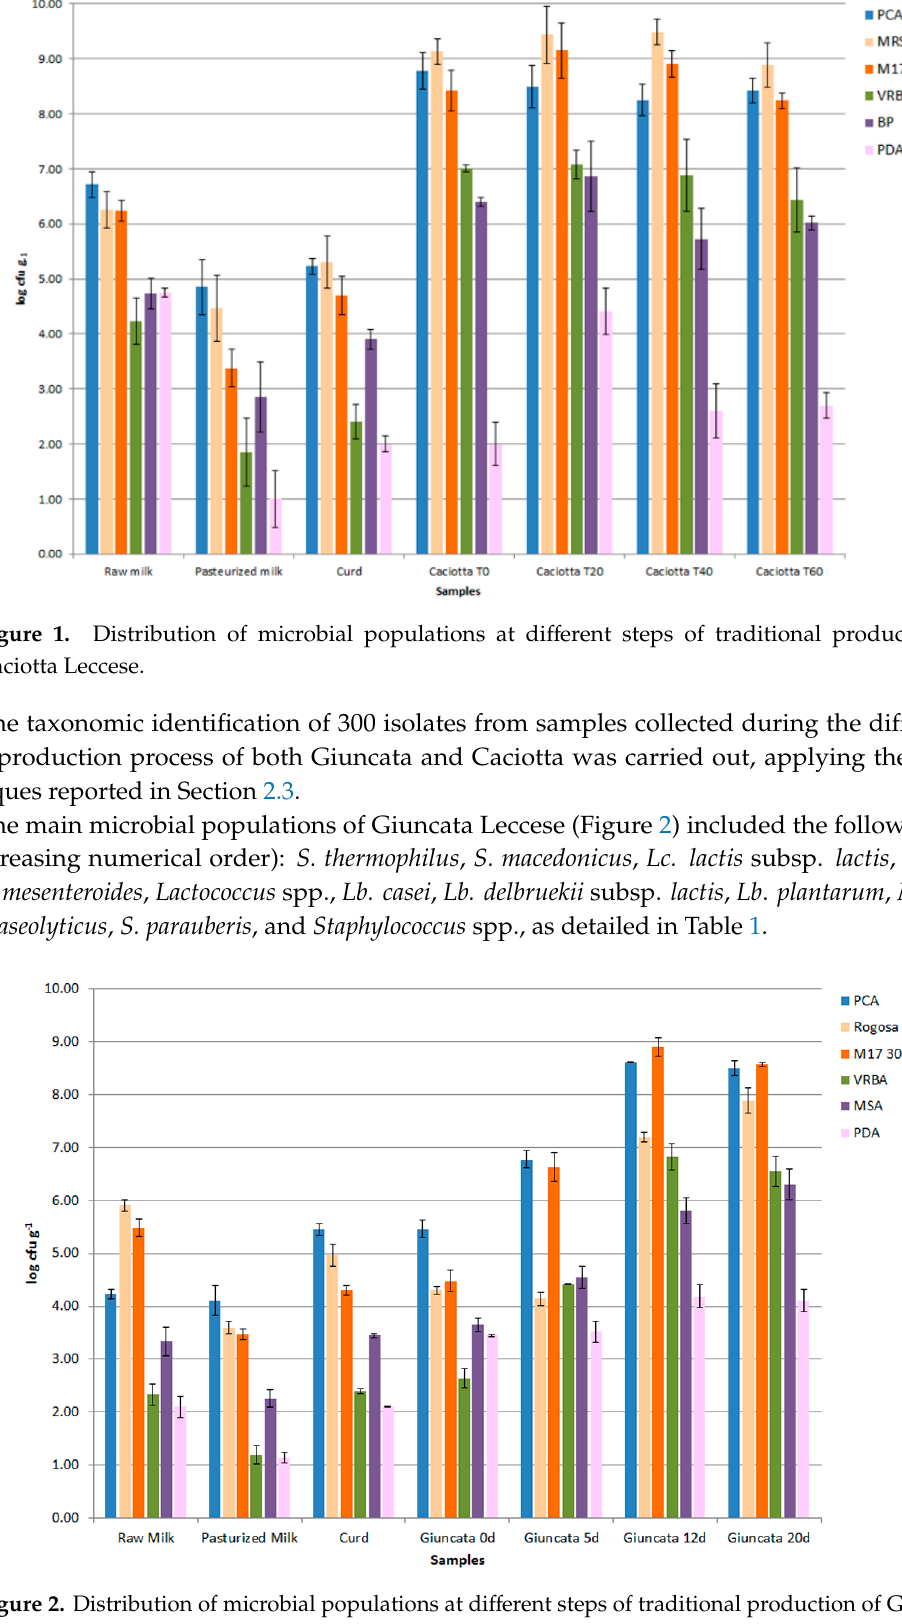
Figure 2. Distribution of microbial populations at different steps of traditional production of Giuncata Leccese, and during its storage at 10 °C for 20 days.